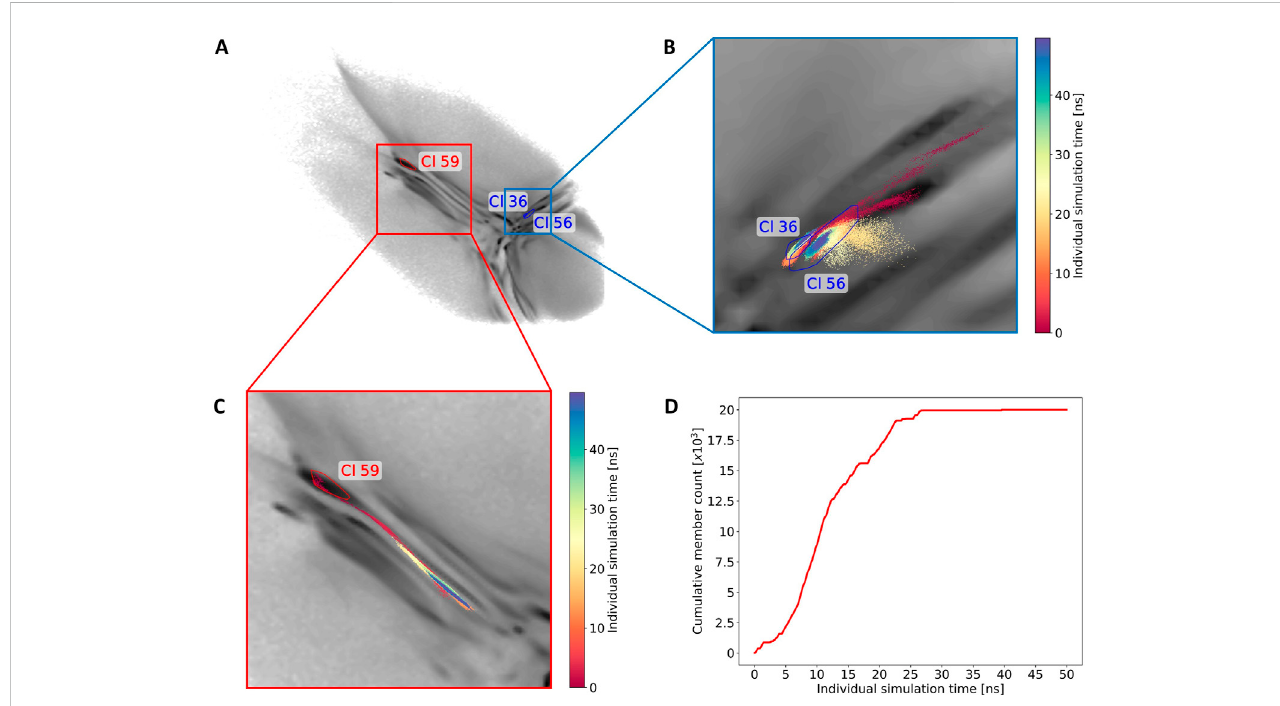
FIGURE 8 Monitoring of the sampling for three selected clusters. (A) The convex hulls of clusters 36, 56 and 59 in the 2D map. (B) A projection of one exemplary trajectorythatcontributestotheformingofclusters36and56.Thetrajectoryiscoloredbasedonthesimulationtime(staringfromredtoblue). (C) Exampleof one trajectory that leaves cluster 59. (D) The cumulative count of frames contributing to cluster 59 over the individual simulation